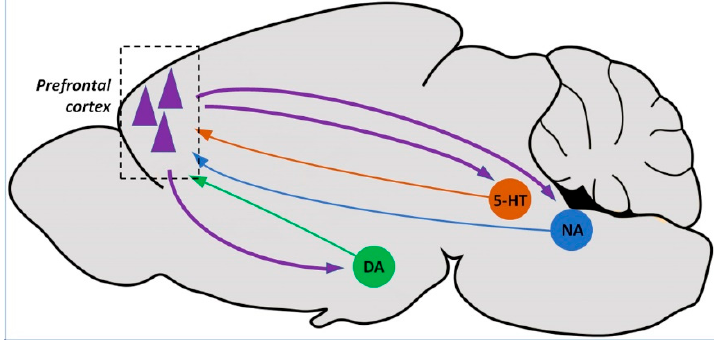
Figure 5. Prefrontal pyramidal neurons (dashed line square) project to the dopaminergic neurons of the ventral tegmental area, serotonergic neurons of the dorsal raphe nucleus and noradrenergic neurons of the locus coeruleus. Neurons from these monoaminergic nuclei send projections back that modulate the neuronal activity of prefrontal cortex.